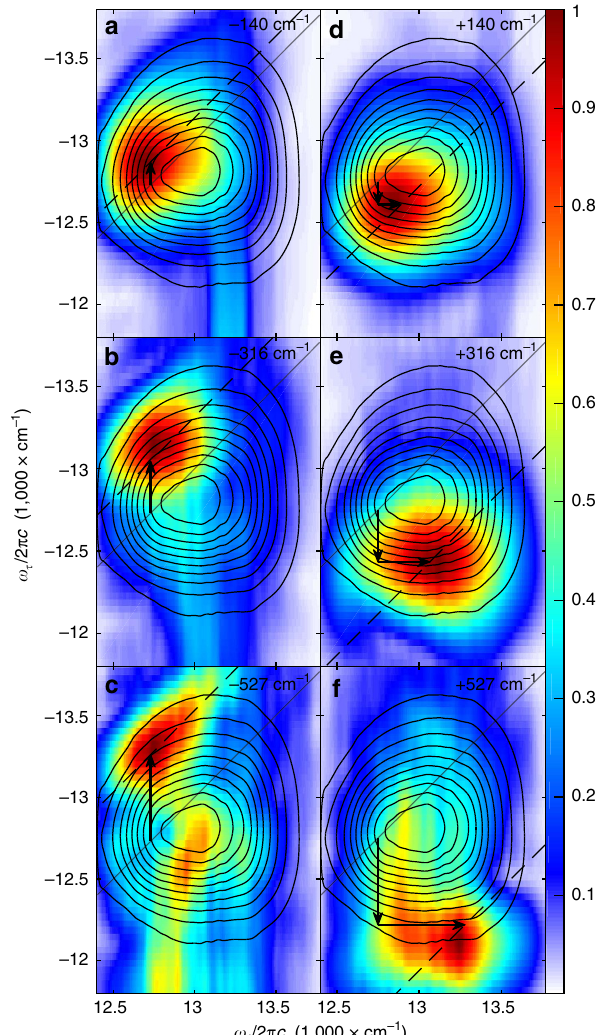
Figure 4 | Beating signatures in the 6WM GAMERS spectrum of IR-140. Beating maps are constructed from diagonal peaks (that is, o T ( a ) (cid:4) 140cm (cid:4) 1 , ( b ) (cid:4) 316cm (cid:4) 1 , ( c ) (cid:4) 527cm (cid:4) 1 , ( d ) 140cm (cid:4) 1 , ( e ) 316cm (cid:4) 1 and ( f ) 527cm (cid:4) 1 in the 4D Gradient-Assisted Multidimensional Electronic Raman spectrum (GAMERS). A contour plot of the absolute value six-wave mixing 2D electronic slice (6WM-2DES) spectrum at T 0 ¼ 0 and T ¼ 100fs is overlaid for reference. Dashed lines are displaced from the diagonal (solid line) by the o T along ( d – f ) the o t and o t dimensions or ( a – c ) the o t dimension only.